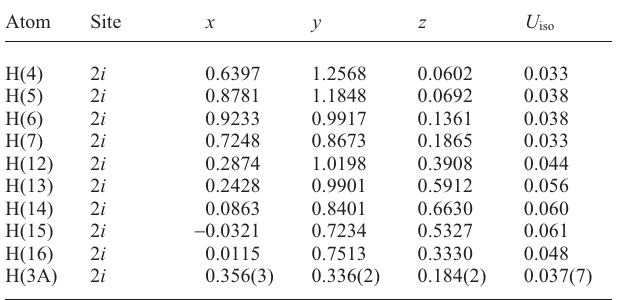
Table 3. Atomic coordinates and displacement parameters (in Å 2 )